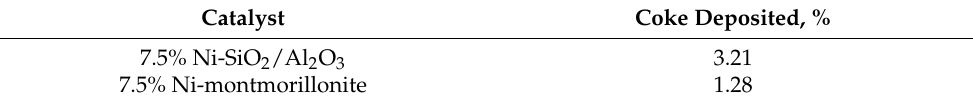
Table 8. Coke deposited on catalysts.